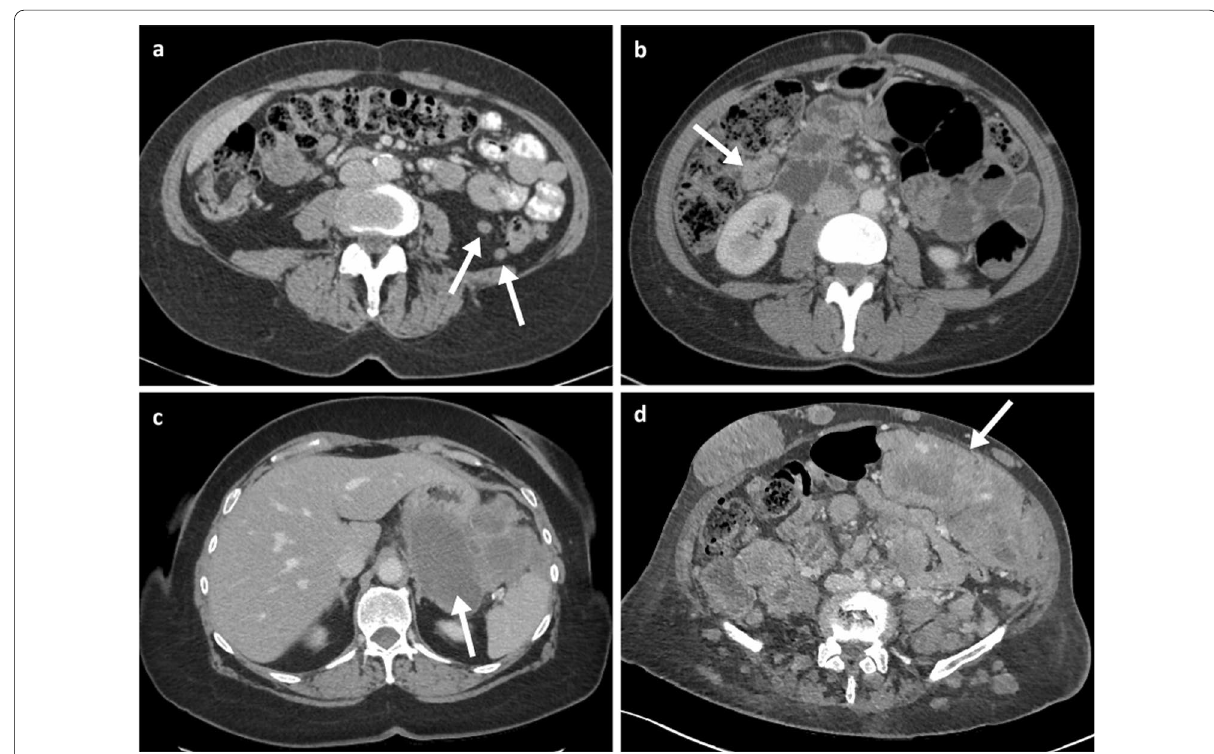
Fig. 15 Peritoneal metastatic melanoma cases. a Oral and intravenous portal phase contrast-enhanced CT axial of 65-year-old left female with paracolic gutter nodules (arrows). b Portal phase contrast-enhanced CT axial of a 45-year-old female patient with a peritoneal deposit adjacent to the hepatic flexure (arrow). c Portal phase contrast-enhanced CT axial of a 73-year-old female patient with a large left upper quadrant necrotic peritoneal mass (arrow). d Portal phase contrast-enhanced CT axial of a 61-year-old female patient with a large left iliac fossa necrotic peritoneal mass (arrow) as well as numerous peritoneal, retroperitoneal and cutaneous